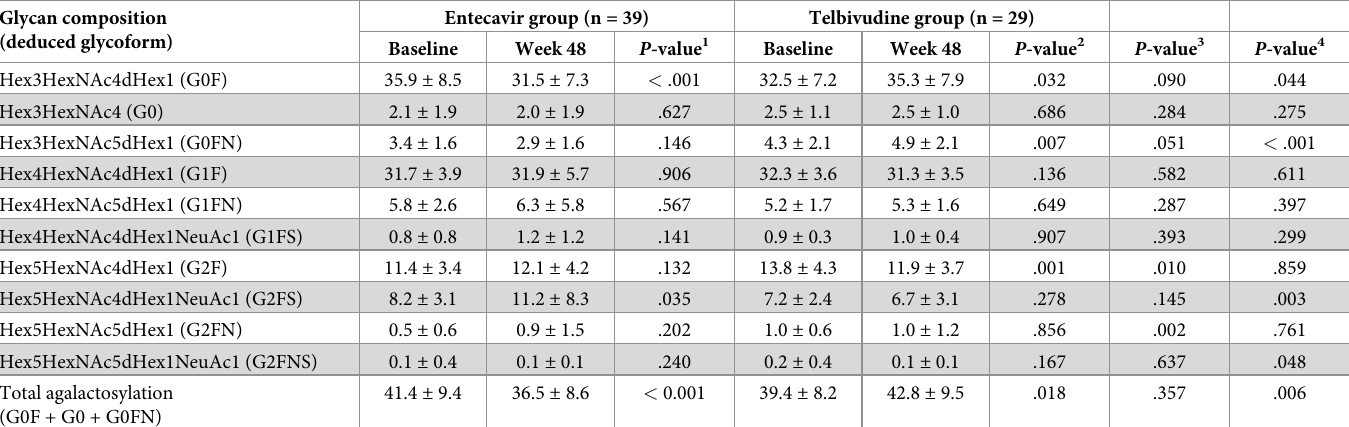
Data are shown in mean values ± standard deviations.